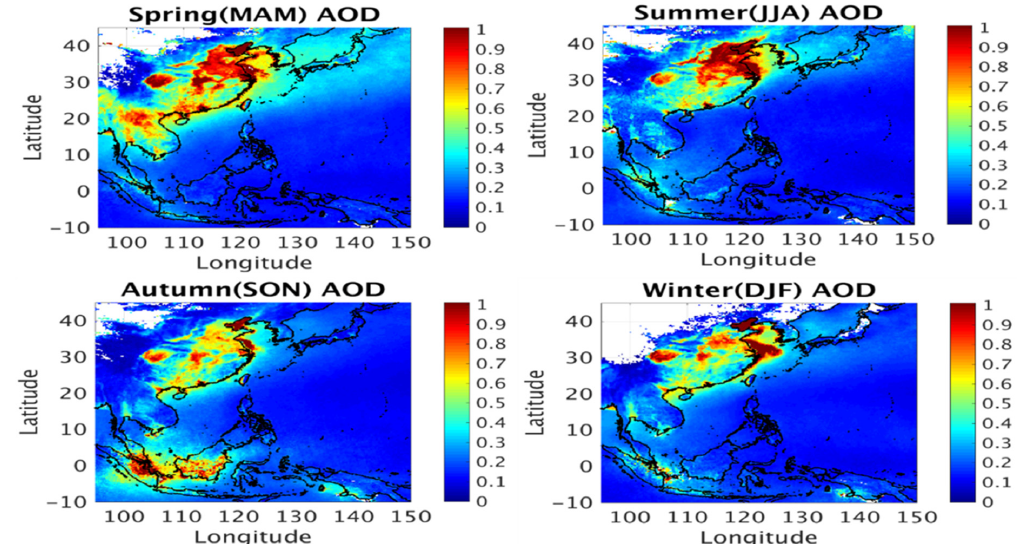
Figure 2. Spatial distribution of aerosol optical depth (AOD) from Aqua moderate-resolution imaging spectroradiometer (MODIS) for each season in East Asia 2005–2015.